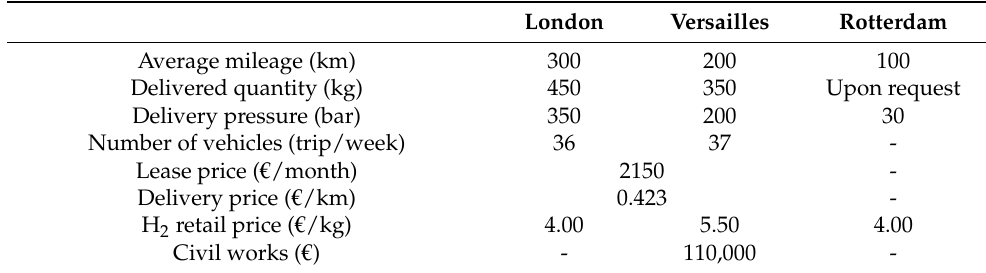
Table 3. Data used for the evaluation of the delivery